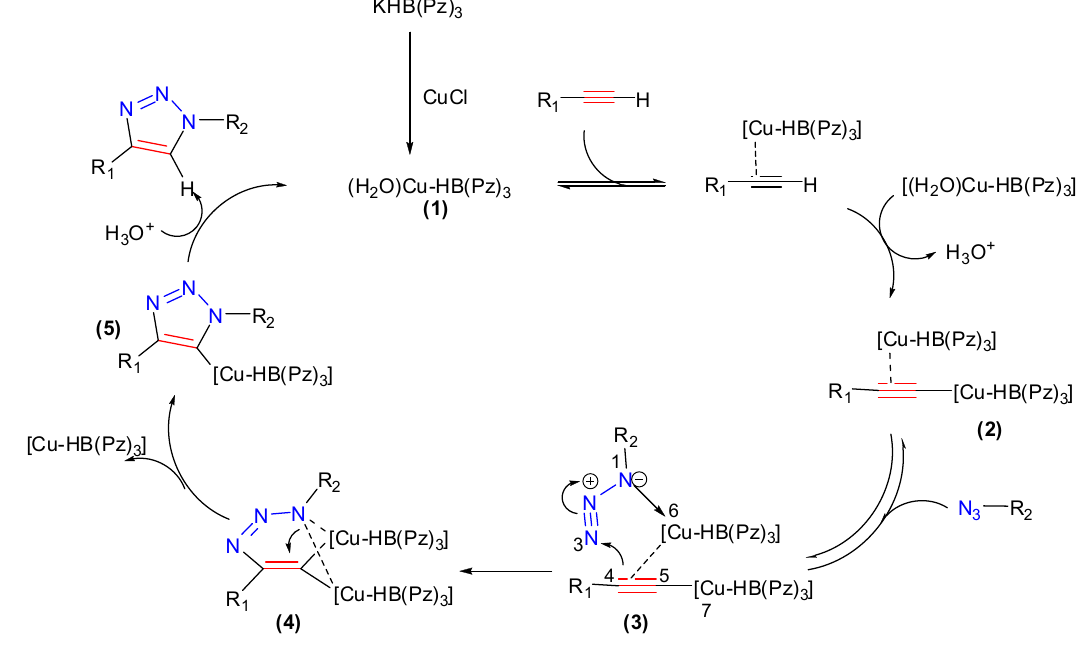
Figure 5. The proposed mechanism for the formation of 1,2,3-triazole catalyzed by the poly(pyrazolyl)borate-copper(I) catalyst.